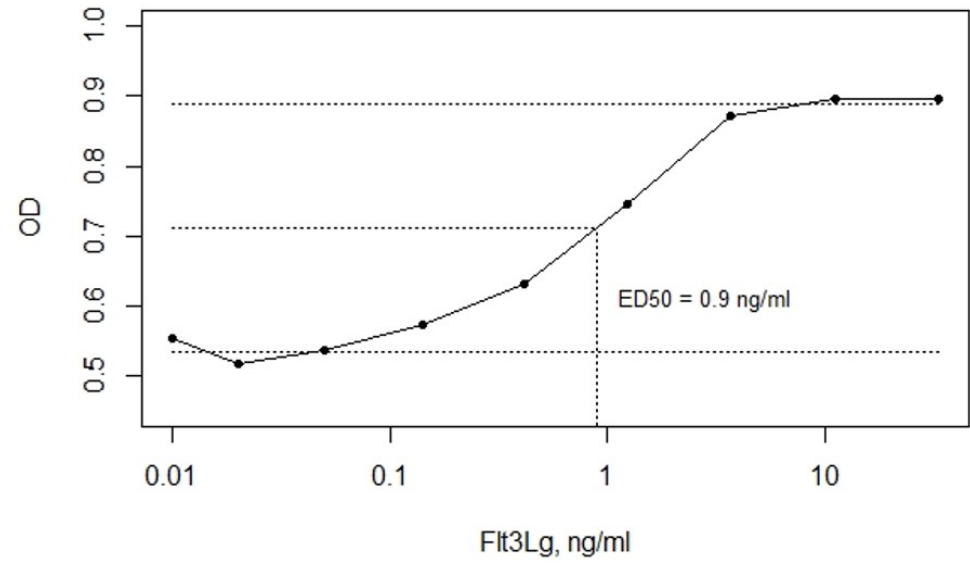
Figure 6. The soluble Flt3Lg-induced proliferation of THP-1 cells, evaluated by MTS assay, with ED50 = 0.9 ng/mL determined using mean OD values of lower and upper plateaus. The data are represented as means ± SD. OD stands for sample optical density.